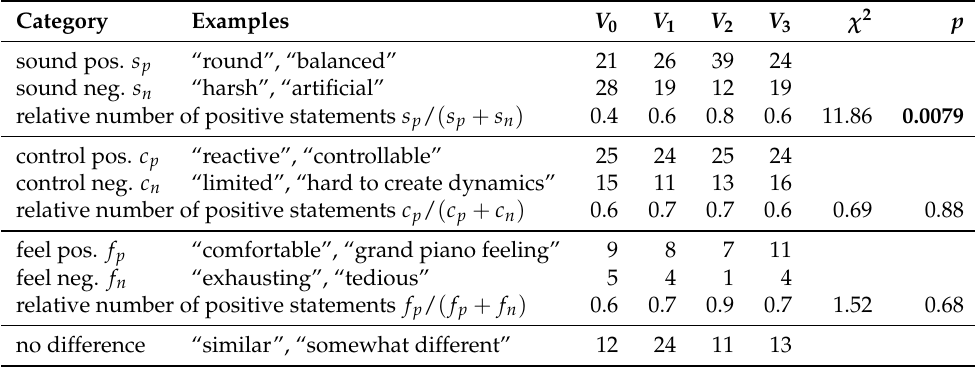
Table 1. Evaluation per vibration level derived from the free verbalizations of the pianists. The number of positive and negative statements per category was counted for each vibration level ( V 0 , V 1 , V 2 , V 3 ). The frequency counts were evaluated with χ 2 -tests. The χ 2 -statistics and p -values are given for each category; p < 0.05 is highlighted in